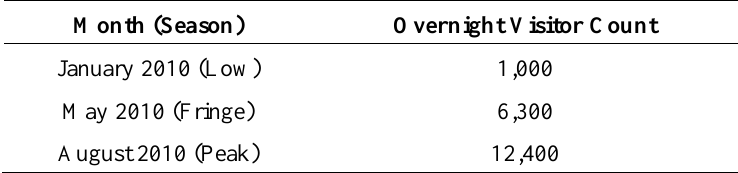
Table 2. Overnight visitor estimates within the St Austell study